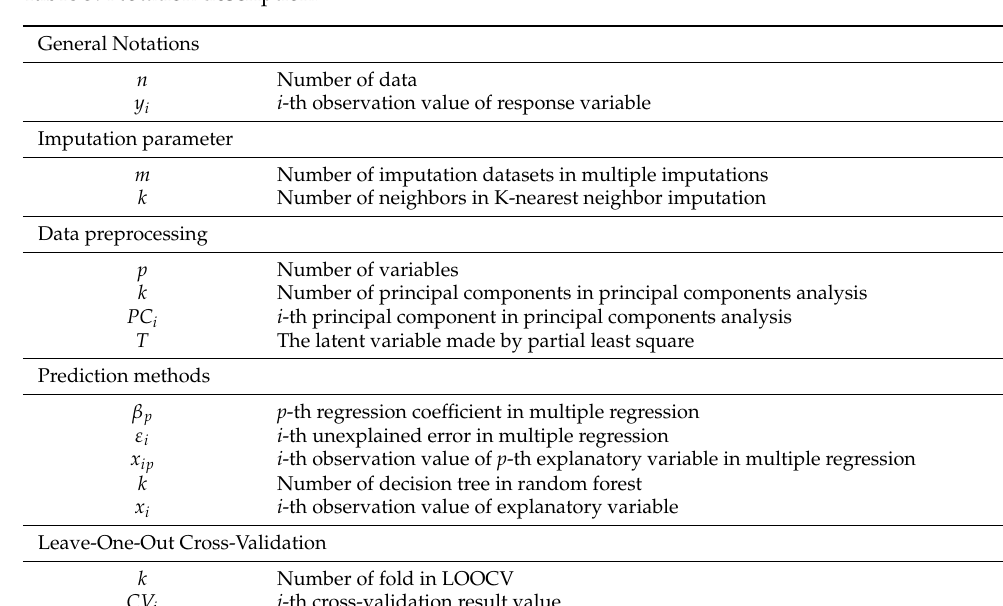
Figure 2. The overall workflow of the conducted study. Table 3. Notation